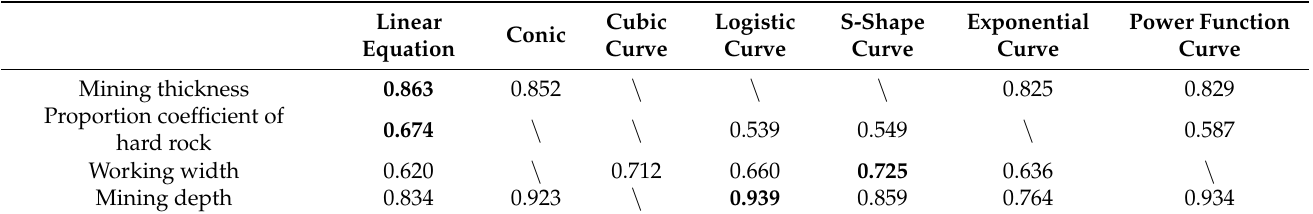
Table 2. Comparison of correlation coefficients of optimal function model with one variable. Cubic Logistic S-Shape Exponential Power Function Linear Conic Curve Curve Curve Curve Curve Equation